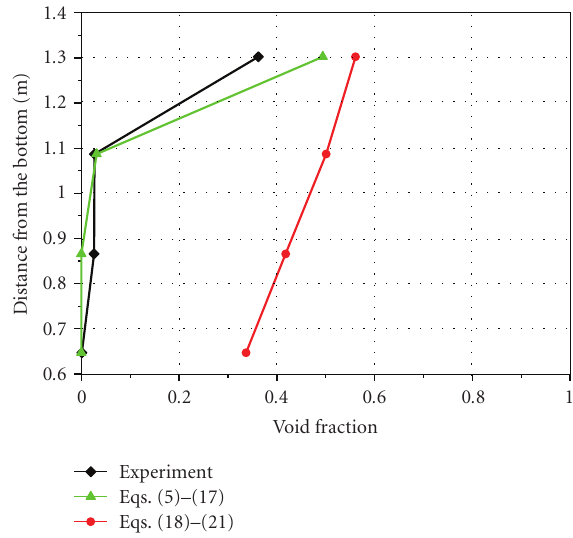
Figure 8: Void fraction profile along height of the area between the SPS bead and SG wall in the experiment and in the calculations with the use of the models (5)–(17) and (18)–(21).